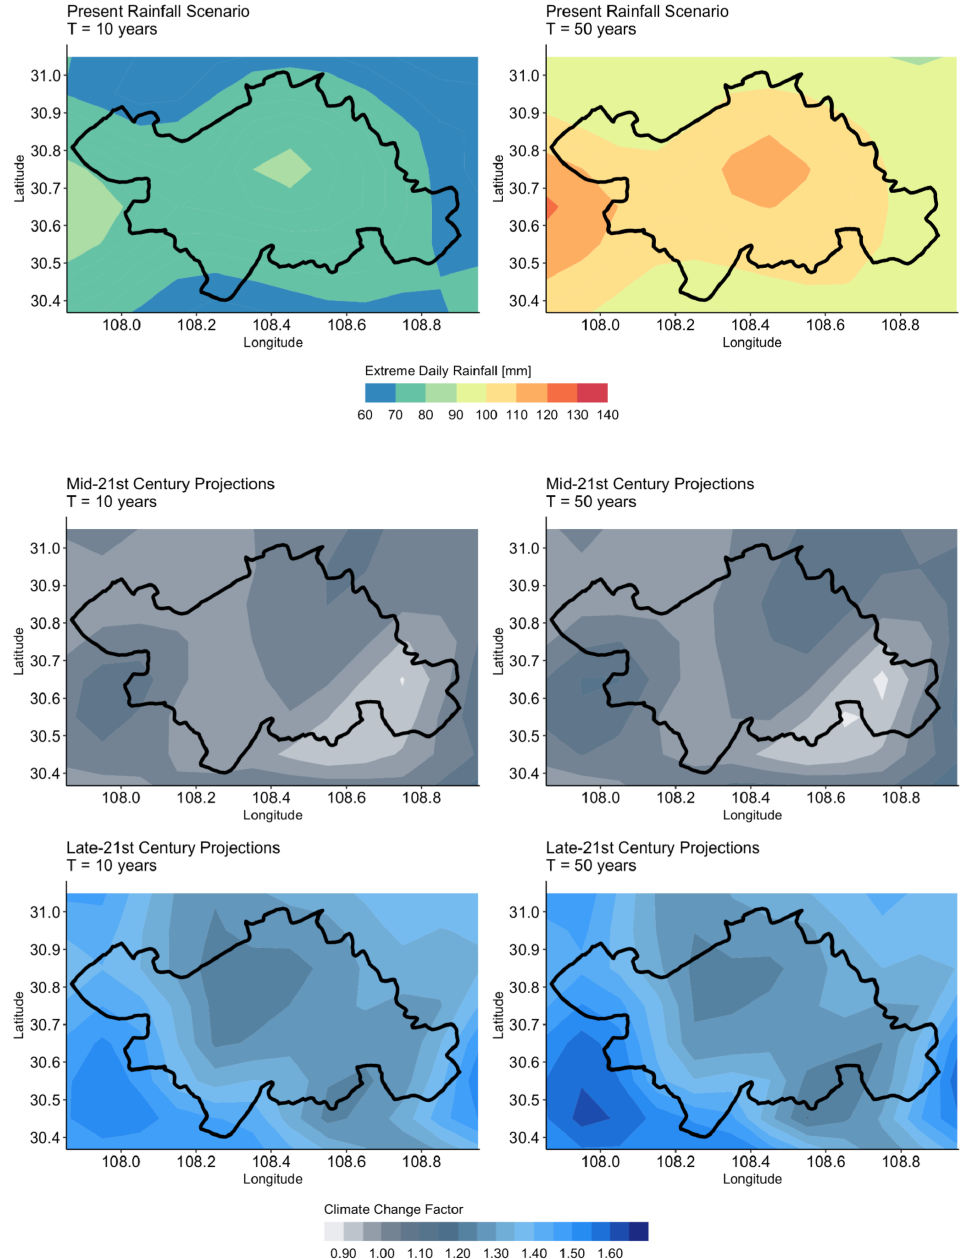
Figure 7. Extreme daily rainfall magnitudes in the present, and climate change factors for the projec- tions in the ( CCF EDR, T ) mid-21st century and late-21st century; The return periods ( T ) considered were 10 and 50 years.